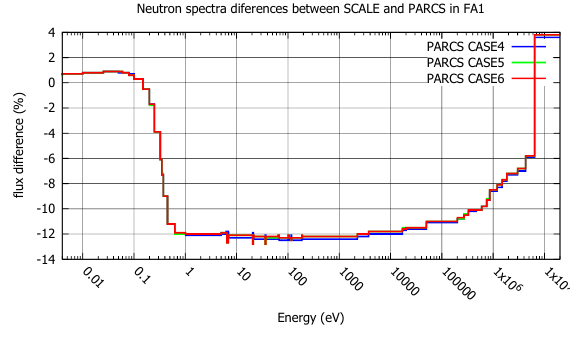
Figure 11. Relative difference in spectra between SCALE and PARCS calculation for FA1 for 0.7% fuel